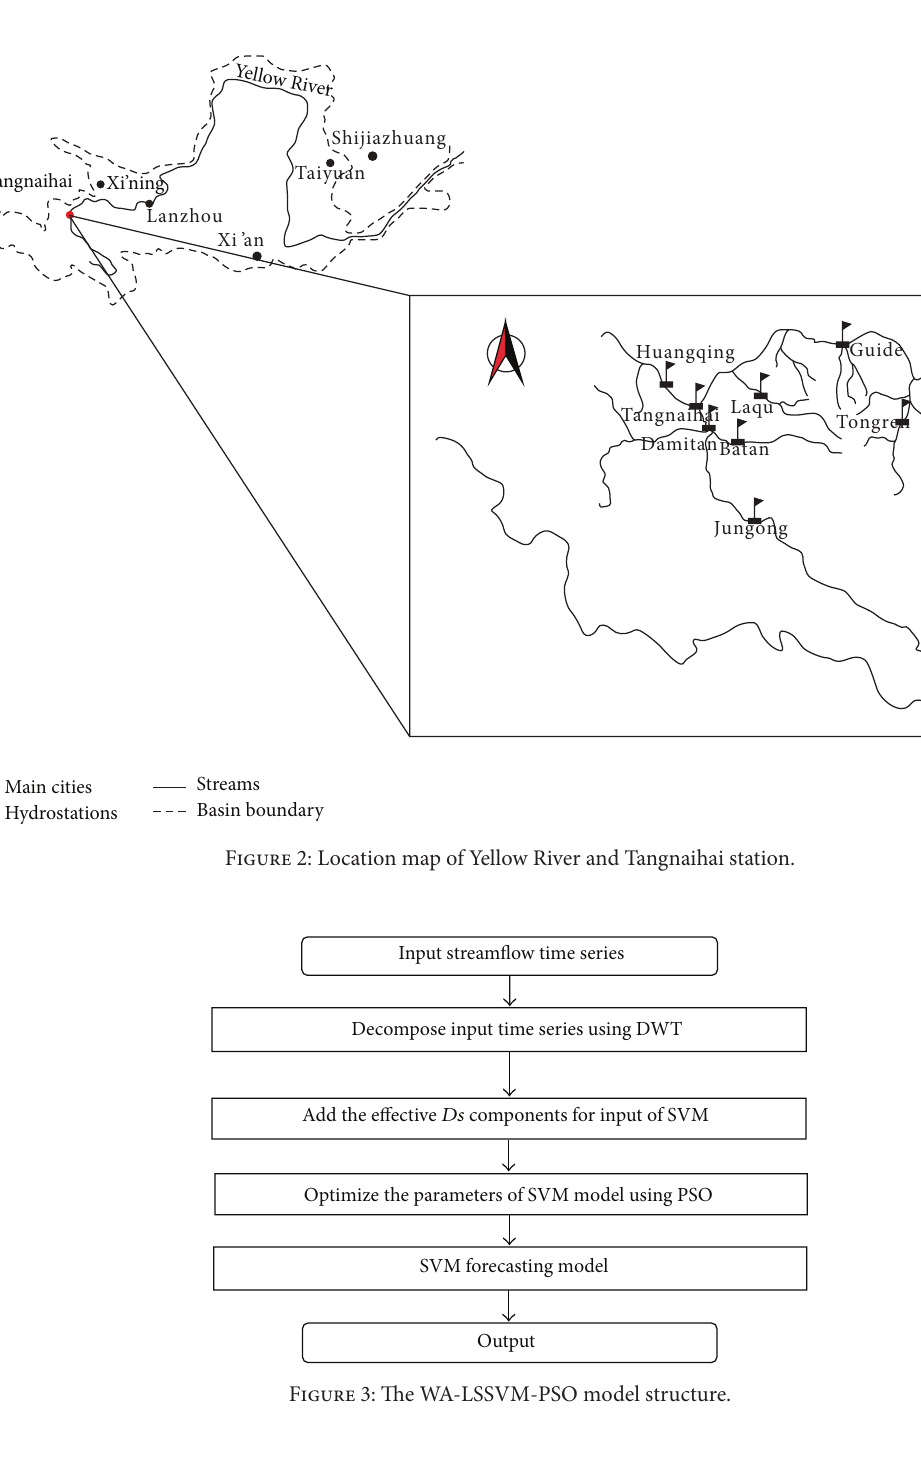
Table 2: Optimal parameters of SVM and WSVM